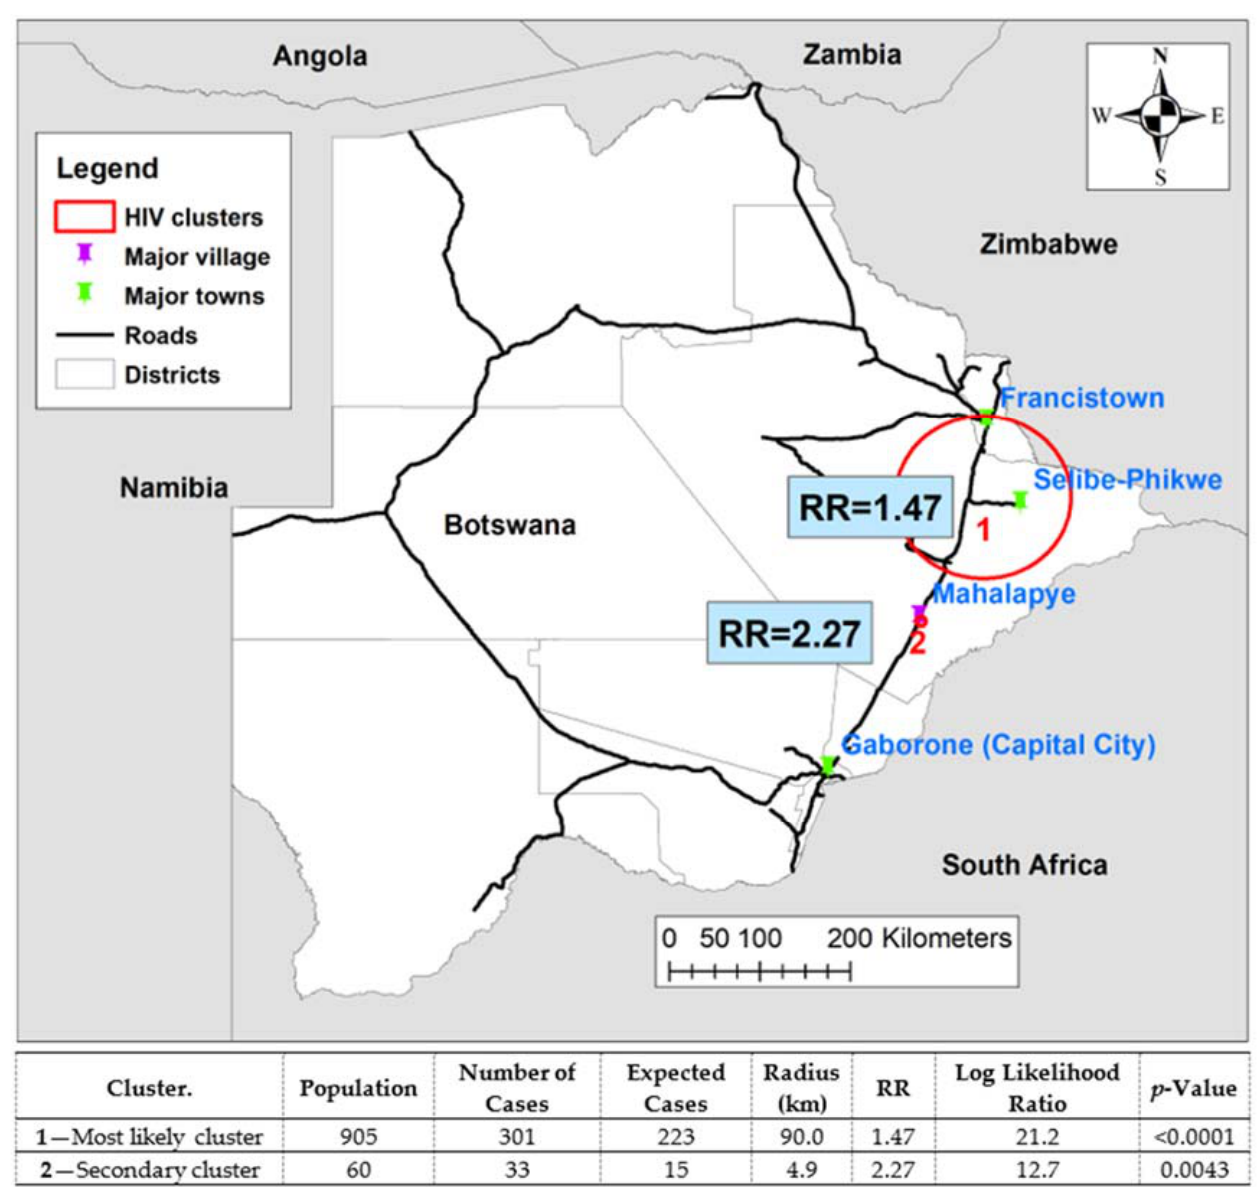
Figure 2. Clusters with high HIV prevalence in Botswana and summary statistics of significant clusters from SaTScan using a Bernoulli probability